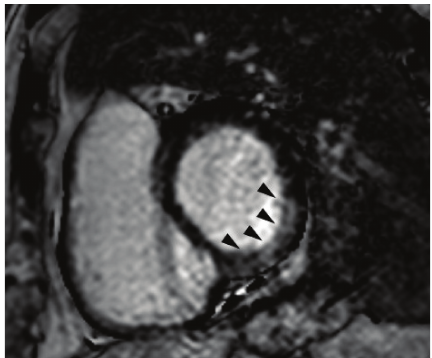
Figure 2: Cardiac magnetic resonance demonstrates late gadolin- ium enhancement (arrows) in the inferolateral left